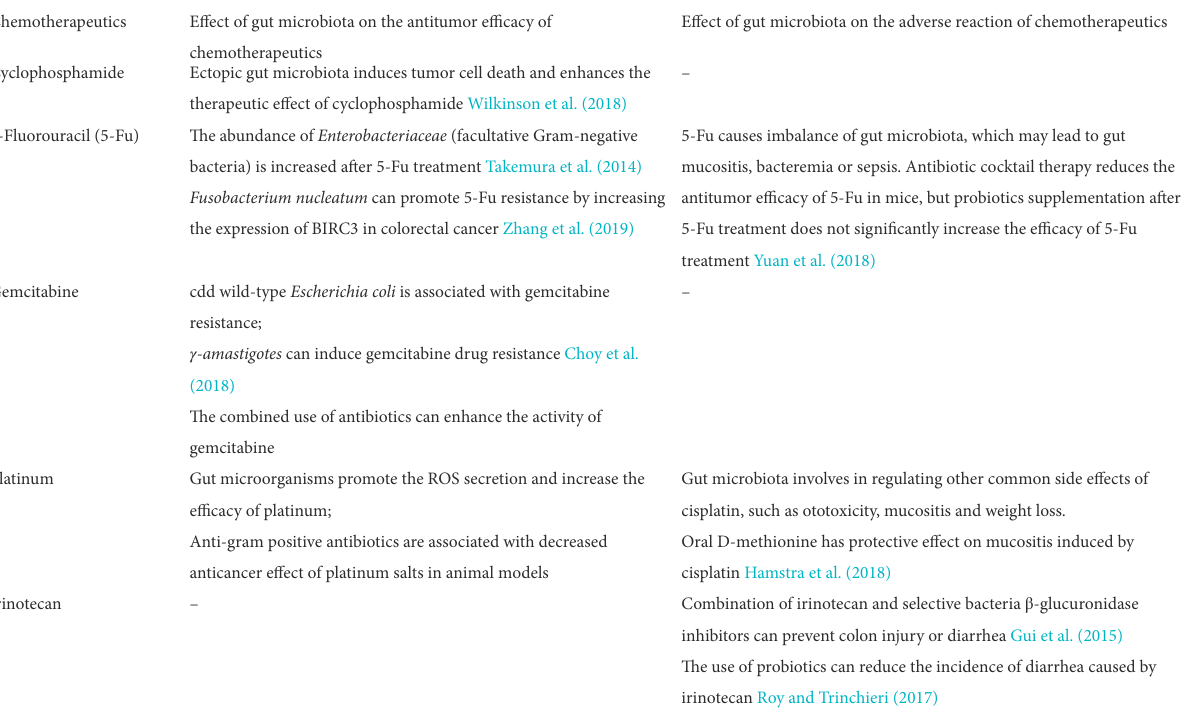
TABLE 1 The effect of gut and tumor microbiota on the antitumor efficacy and adverse reaction of chemotherapeutics. Chemotherapeutics Effect of gut microbiota on the antitumor efficacy of Effect of gut microbiota on the adverse reaction of chemotherapeutics